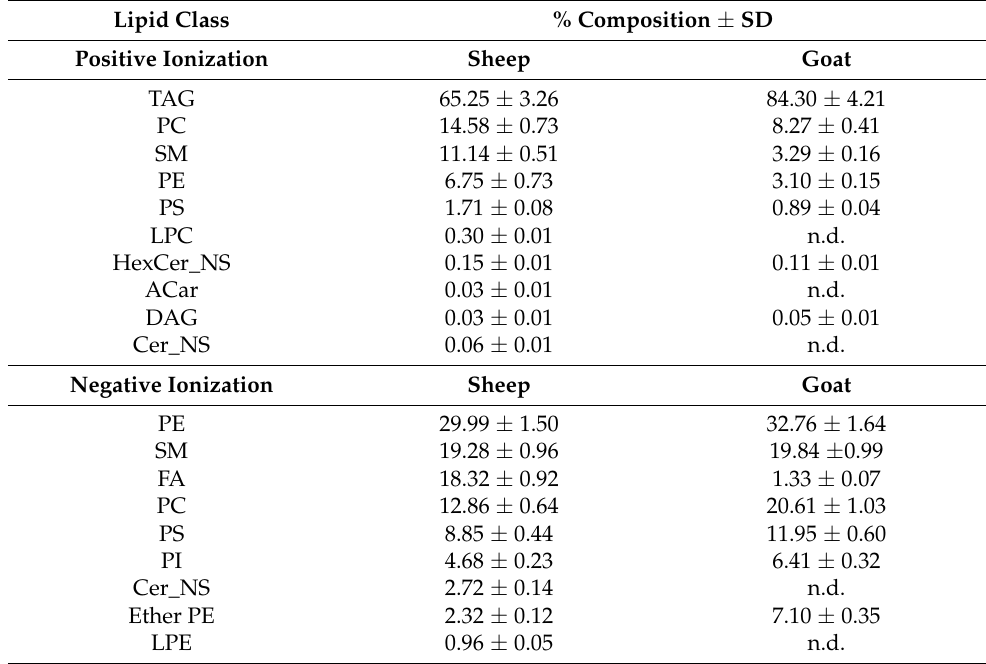
Table 1. Percent compositions based on relative abundance of lipid classes measured in sheep and goat milk